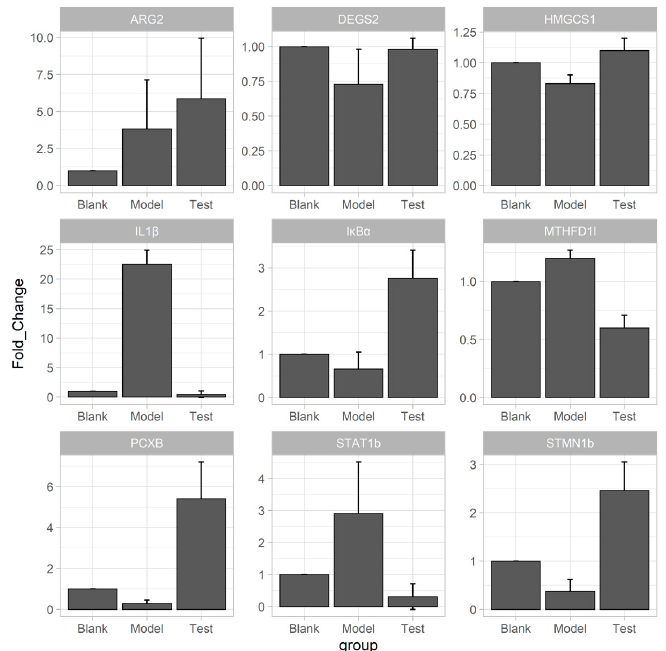
Figure 7. RT-qPCR validation of DEGs related to myricitrin’s regulation.